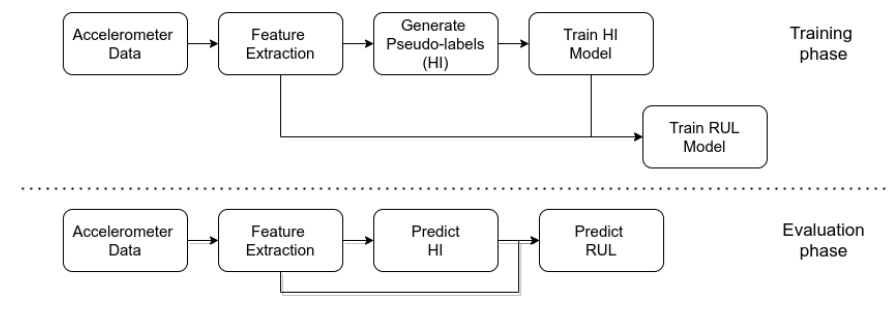
Figure 3. Overview of the pipeline.